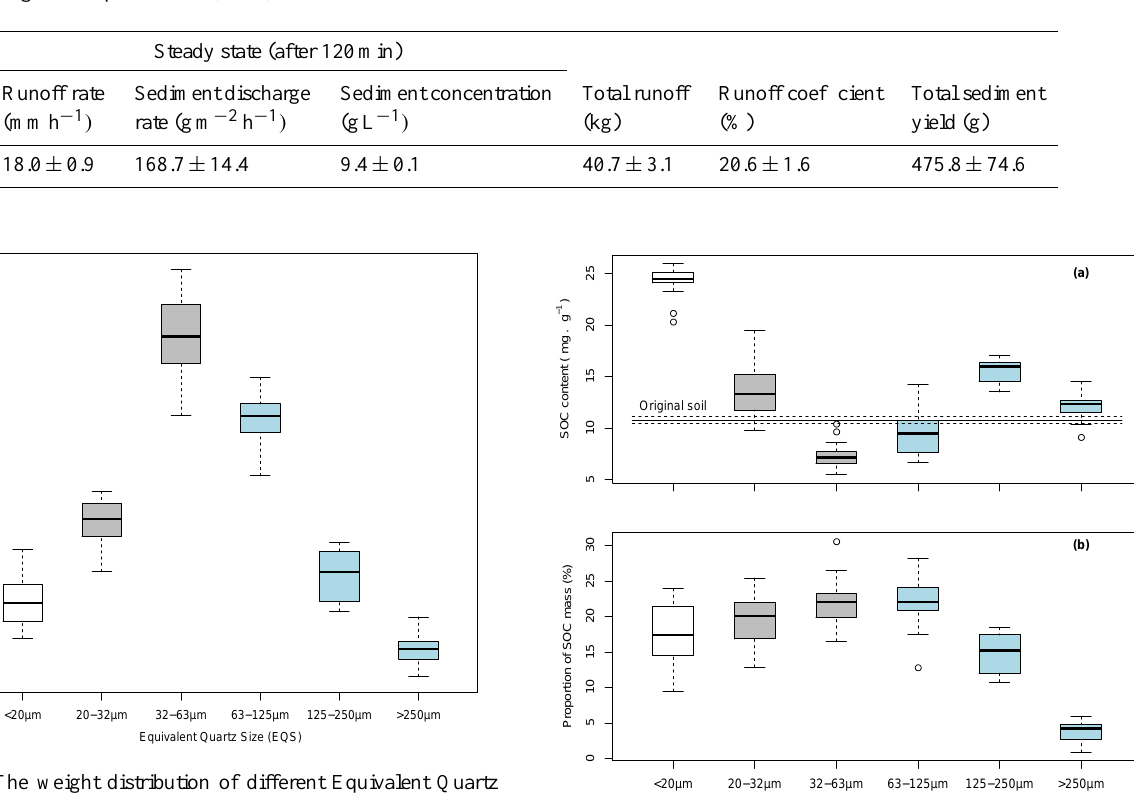
upper quartile ( n =